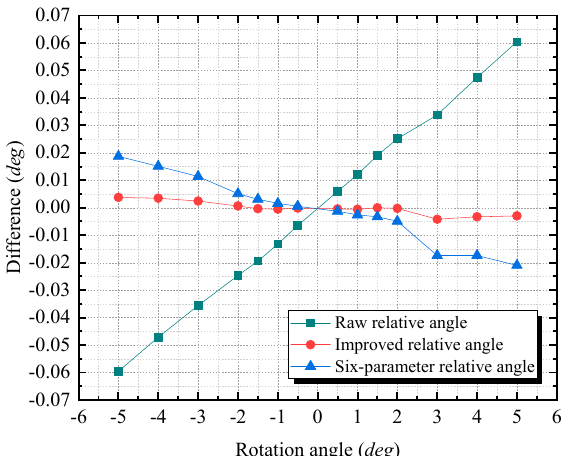
Figure 11. The differences of the measured angles (the raw relative angle, the improved relative angle, and the six-parameter relative angle) from the reference relative angle. The difference is equal to the value measured by different methods minus reference relative angle.